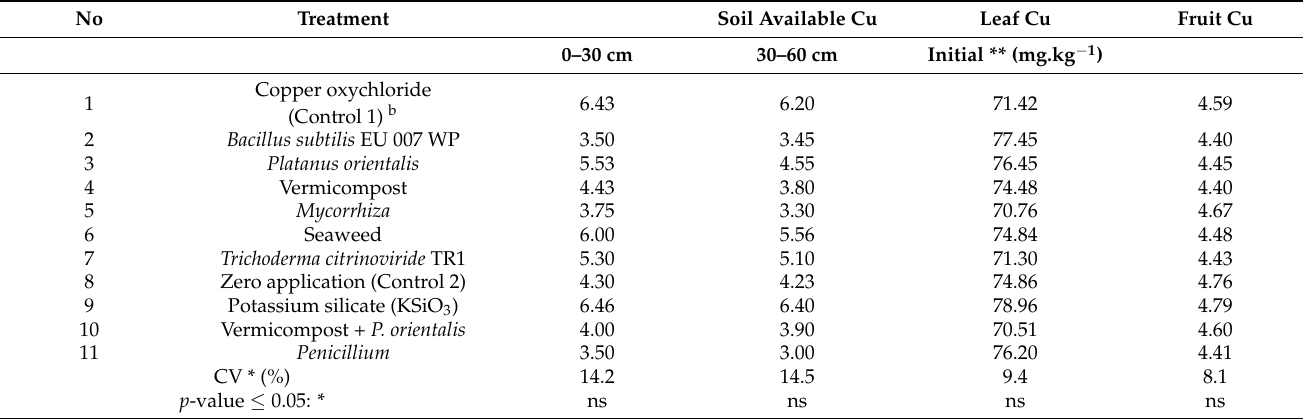
Table 3. Initial copper content a of soil, leaf and fruit samples (sampled in 2018).